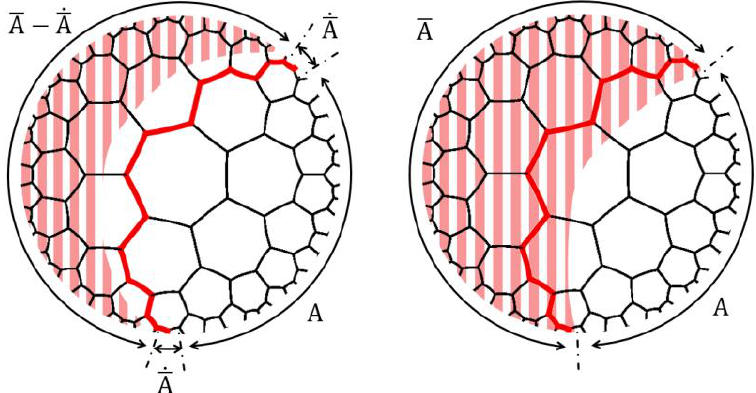
Figure 21 . Boundary e(cid:11)ect of greedy algorithm in the tensor network with f 7 ; 3 g tiling and nh 1 i h 1 0 1 io S c = ; . Interval (cid:22) A is split into (cid:22) A (cid:0) _(cid:22) A and _(cid:22) A . The CP tensor chain is denoted by the 2 1 1 1 polyline in